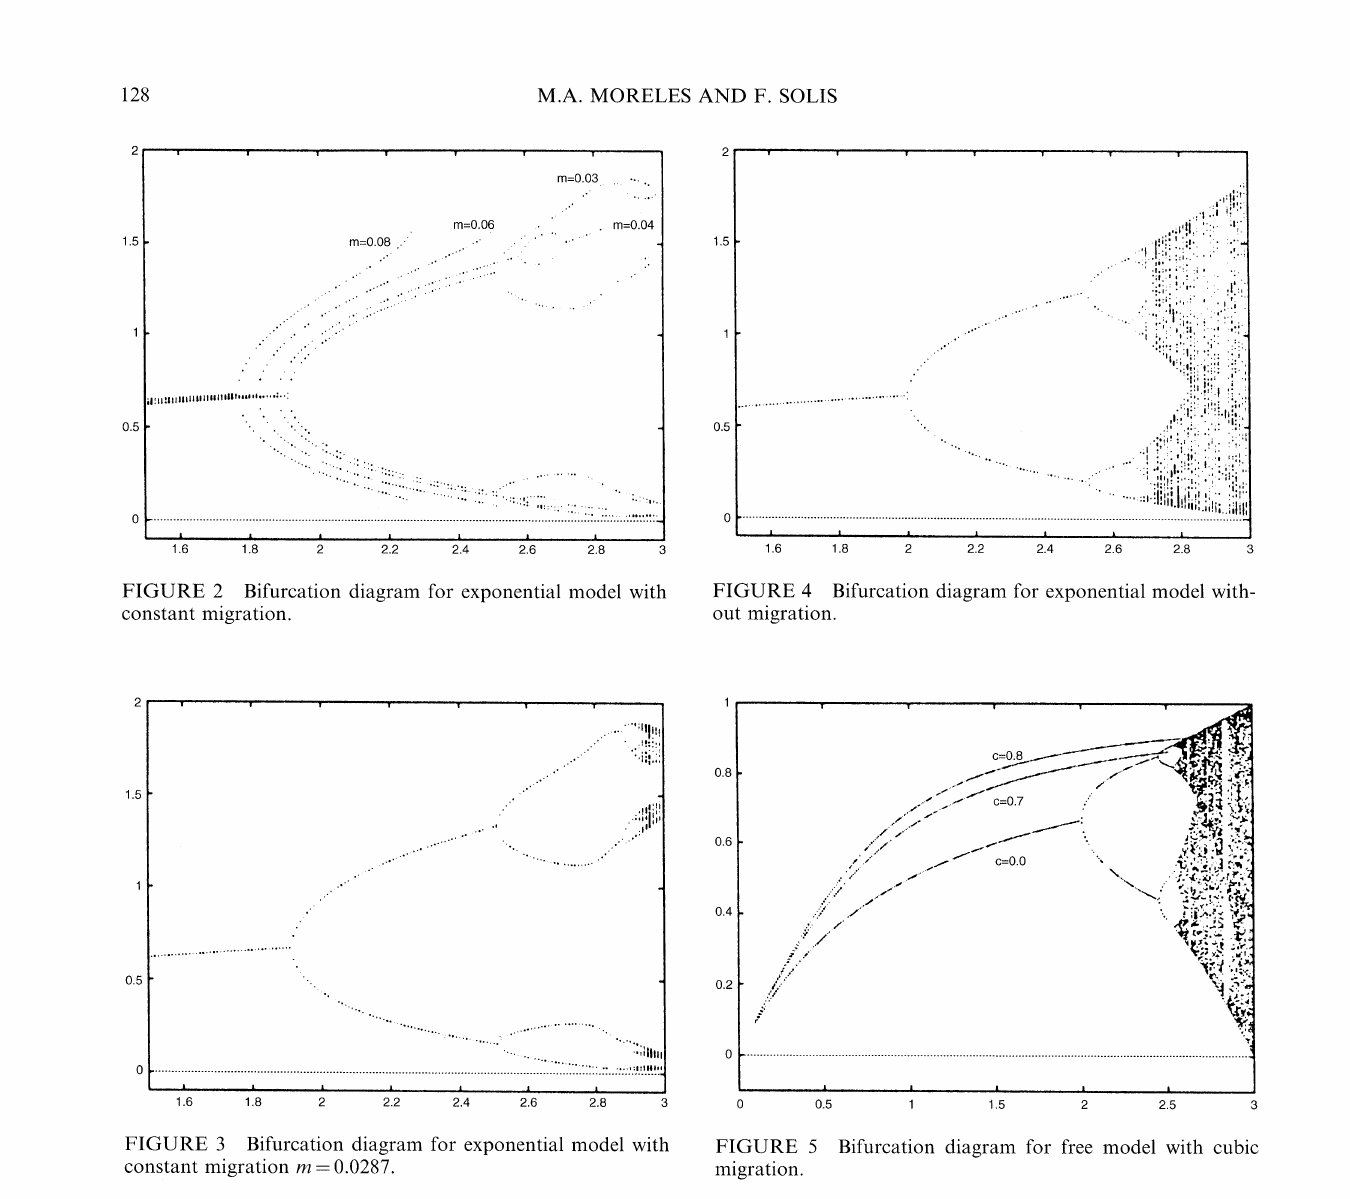
FIGURE 3 Bifurcation diagram for exponential model with constant migration m 0.0287.